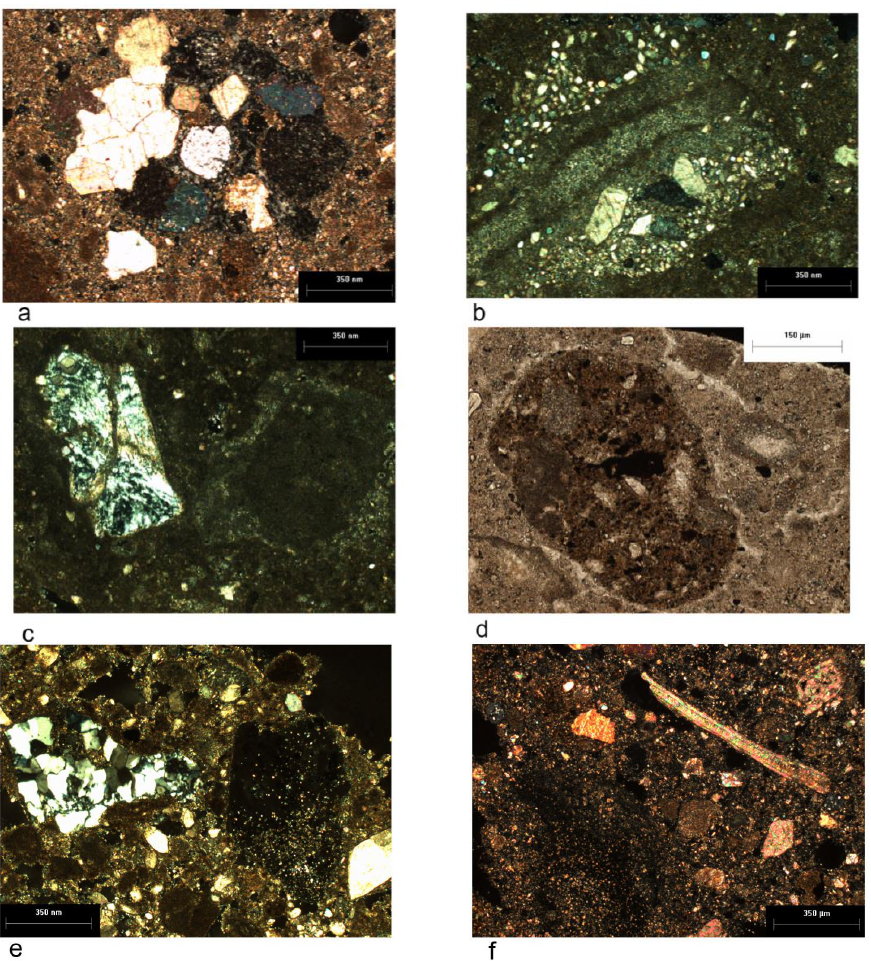
Figure 4. Some inclusions: ( a ) sparitic inclusions (xpl); ( b ) heterogeneous inclusions (xpl); ( c ) clays (xpl); ( d ) soil particle (ppl); ( e ) left, chert (xpl); ( f ) top right, shell (xpl).